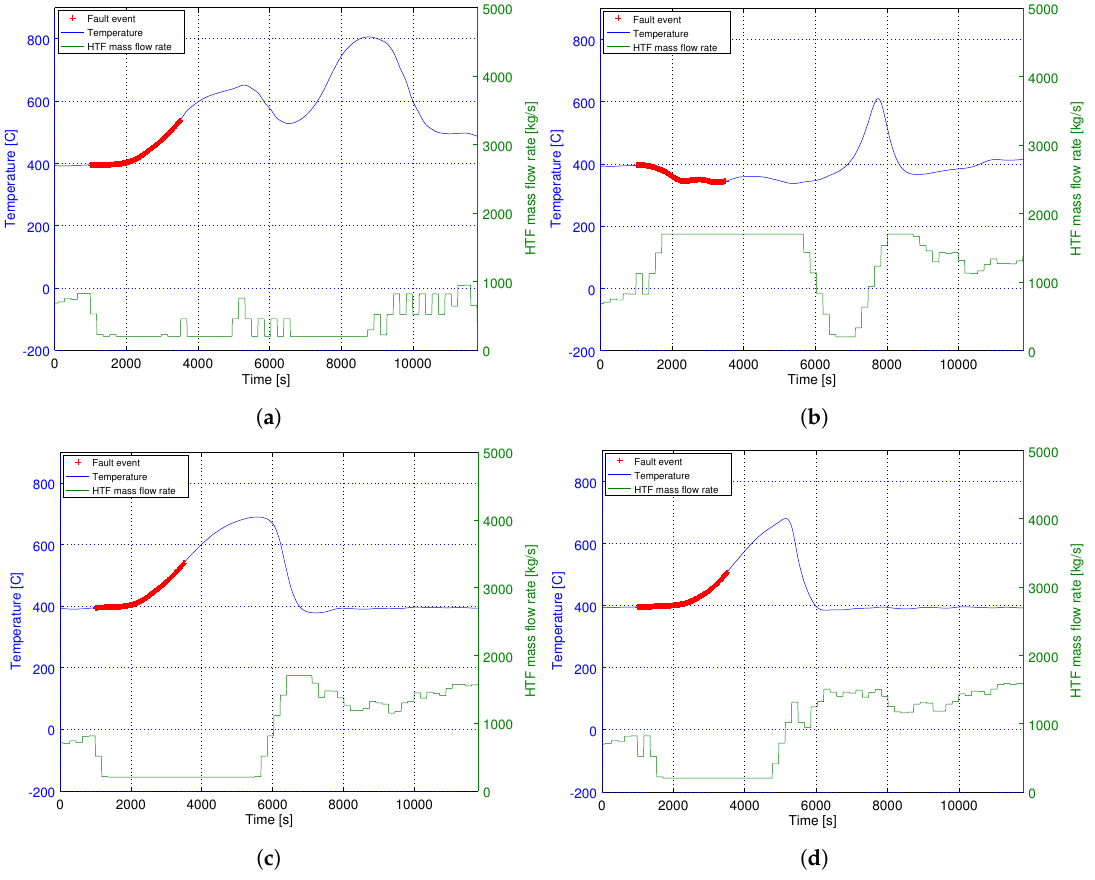
Figure 4. Controller robustness comparison. Linear cases ( a – c ) against nonlinear case ( d ). Time is shown in abscissa. ( a ) linear γ = 0.7; ( b ) linear γ = 0.1; ( c ) linear γ = 0.01; and ( d ) nonlinear γ = 10 − 4